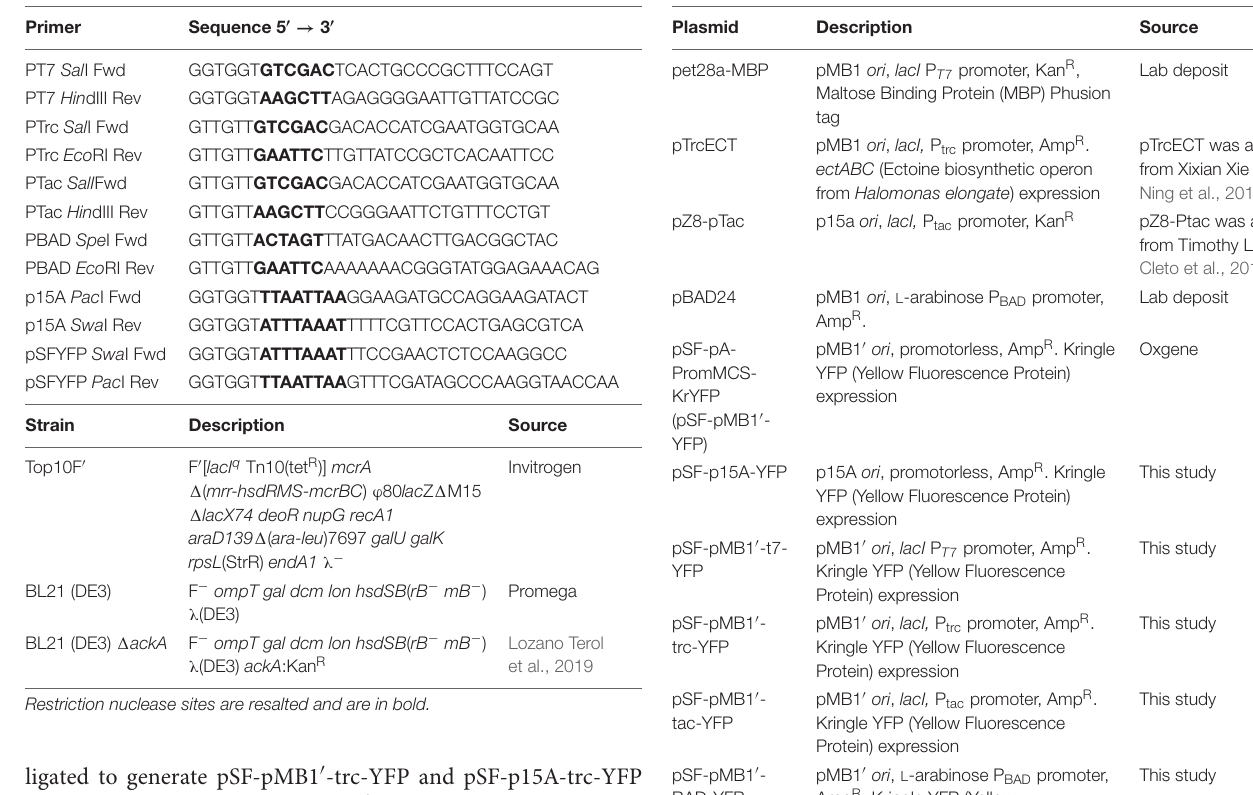
TABLE 1 | Primers and strains used in this study. TABLE 2 | Plasmids used and constructed in this